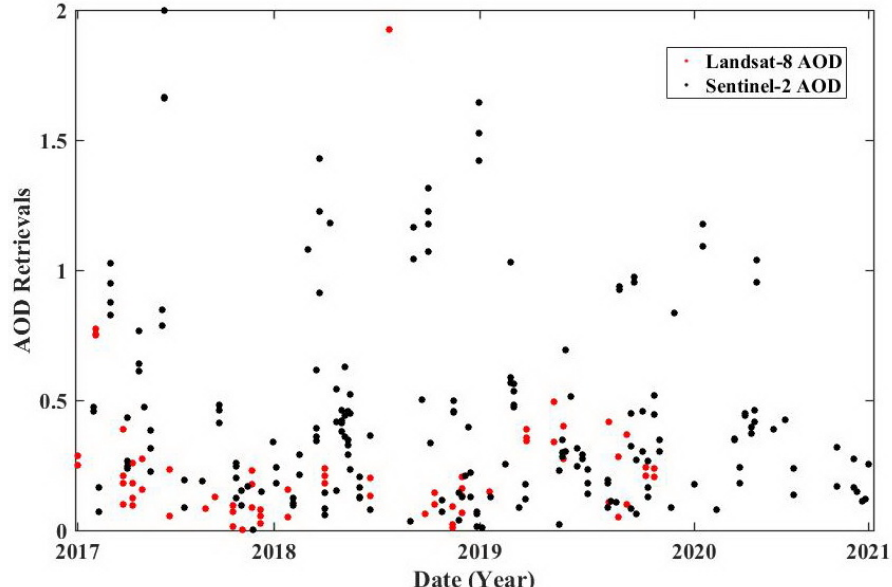
Figure A3. True color image ( a ) and the spatial distribution of different surface types ( b ) over Bei- jing and surrounding areas (Sentinel-2A MSI image in 27 June 2017).